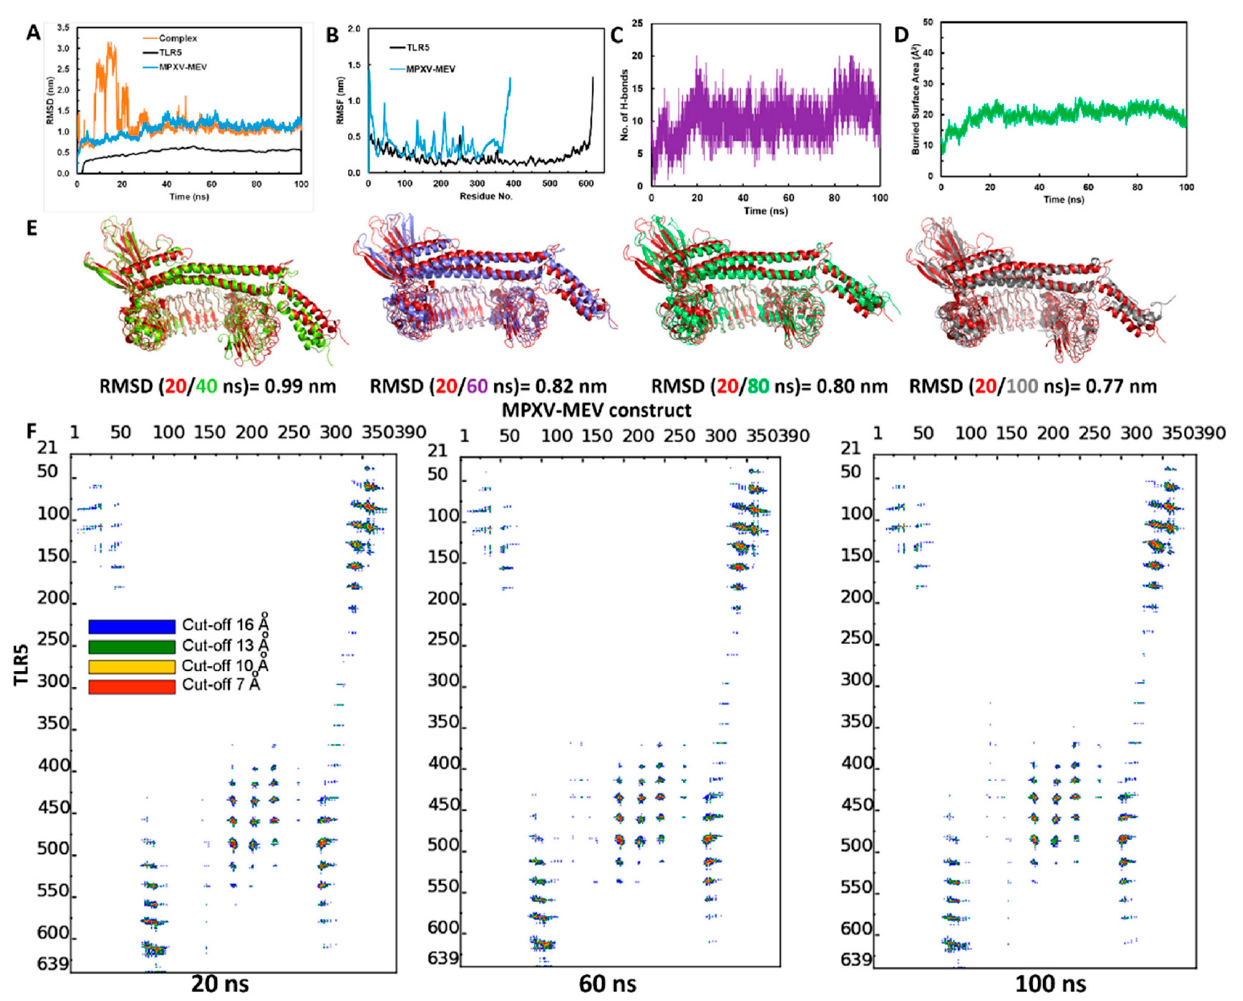
Figure 3. ( A ) Backbone RMSD plots of the docked complex and the individual chains of TLR5 and MPXV-MEV construct; ( B ) RMSF plots; ( C ) Hydrogen bonds analysis between TLR5 and MPXV-MEV during MD simulations; ( D ) Buried area of TLR5 and MPXV-MEV construct; ( E ) Superimposition of snapshots at every 20 ns of the TLR5 and MPXV-MEV constructs with their respective RMSD; ( F ) Contact maps showing inter-molecular contacts where the dots at the crossover of two amino acids have been colored in red, yellow, green and blue if any pair of atoms between two amino acids is closer than 7, 10, 13 and 16 Å.